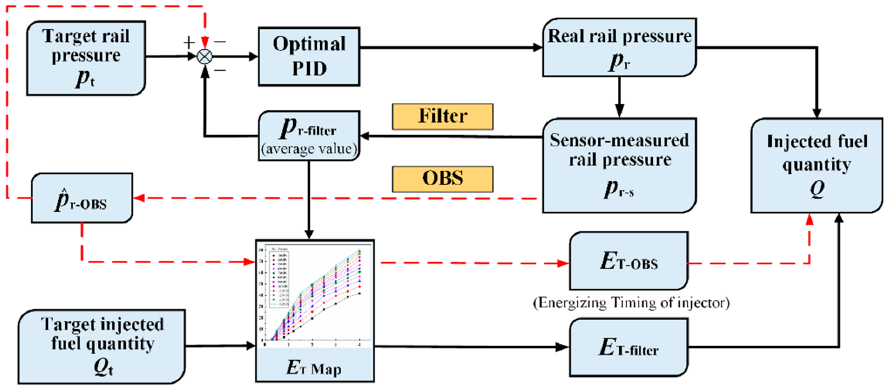
Figure 1. Control principle of common rail systems (CRS). PID: Proportion Integration Differentiation; OBS: rail pressure error state observer.